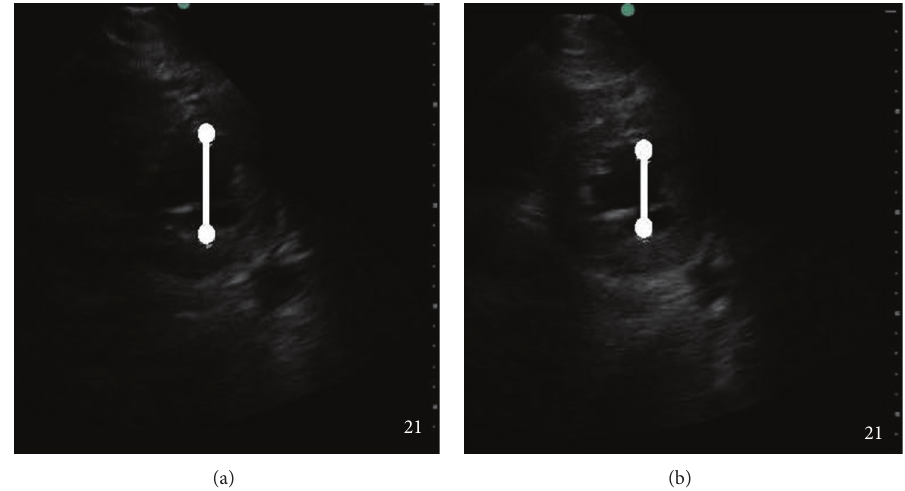
Figure 2: Left-ventricular function at end-systole pre decompression (a) and post decompression (b). There is decreased left-ventricular end-systolic internal diameter (line) and improved wall thickening after